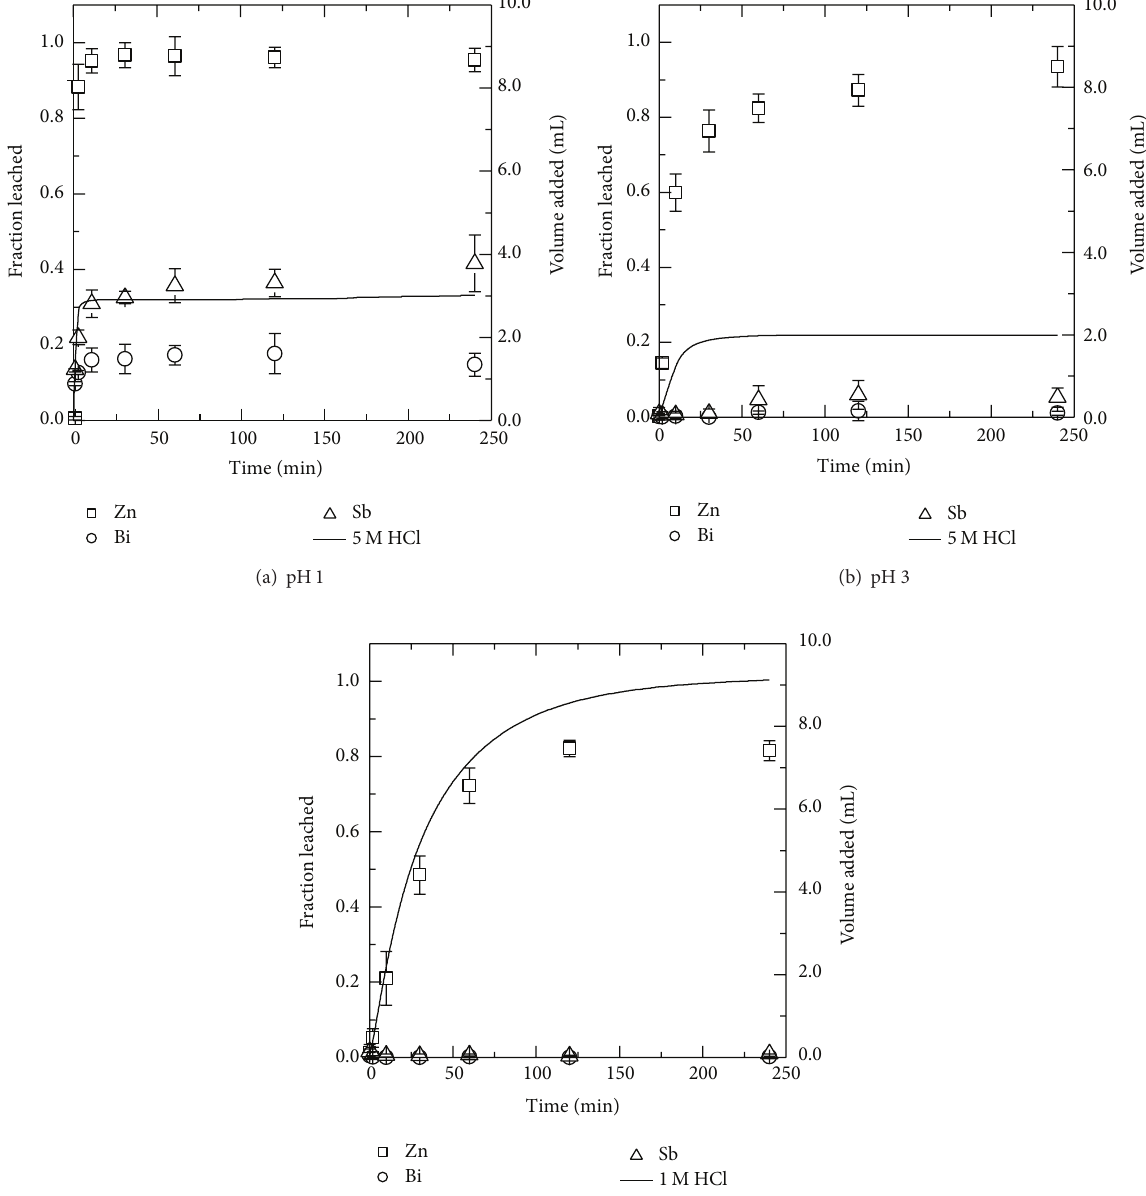
for zinc, bismuth, and antimony. For selective leaching of zinc, pH 1 nitric acid solutions work well due to the